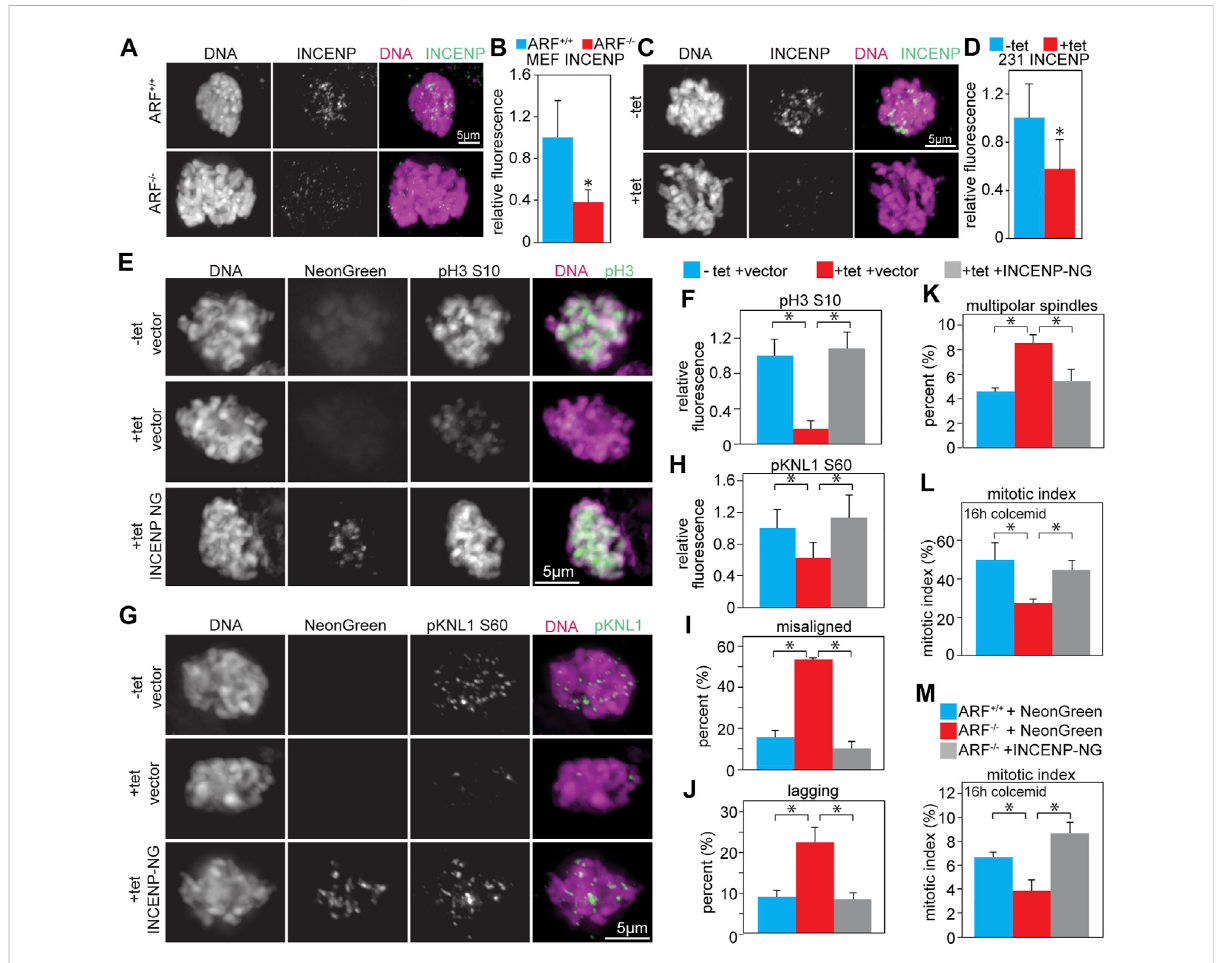
Co-expression of INCENP restores Aurora B kinase activity and rescues mitotic defects. (A – D) Upregulation of Aurora B mislocalizes INCENP. (A) ARF − / − MEFs,whichhaveincreasedlevelsofendogenousAuroraB,havereducedINCENPlocalization totheinnercentromere. (B) Quanti fi cation of INCENP levels in primary MEFs. n > 10 cells from each of 3 independent experiments. (C) Tet-inducible Aurora B expression in MDA-MB-231 cells reduces INCENP localization to the inner centromere. (D) Quanti fi cation of INCENP levels in MDA-MB-231 cells. n > 10 cells from each of 3 independent experiments. (E – L) Infection with lentiviruses expressing INCENP-mNeonGreen (48 h) rescues Aurora B inhibition and mitotic defectscausedbytet-inducedupregulationofAuroraB(48 h). (E – H) AuroraBupregulationreducesphosphorylationofAuroraBsubstrates,butco- expression of INCENP-mNeonGreen restores phosphorylation of pH3 (E – F) and pKNL1 (G – H) . (F,H) Quanti fi cation of pH3 (F) and pKNL (H) levels. n > 10 cells from each of 3 independent experiments. (I – J) Upregulation of Aurora B increases the incidence of misaligned (I) and lagging (J) chromosomes, while expression of INCENP-mNeonGreen in conjunction with Aurora B upregulation rescues this defect. n > 50 metaphase cells (I) or100anaphaseandtelophasecells (J) from3independentexperiments. (K)